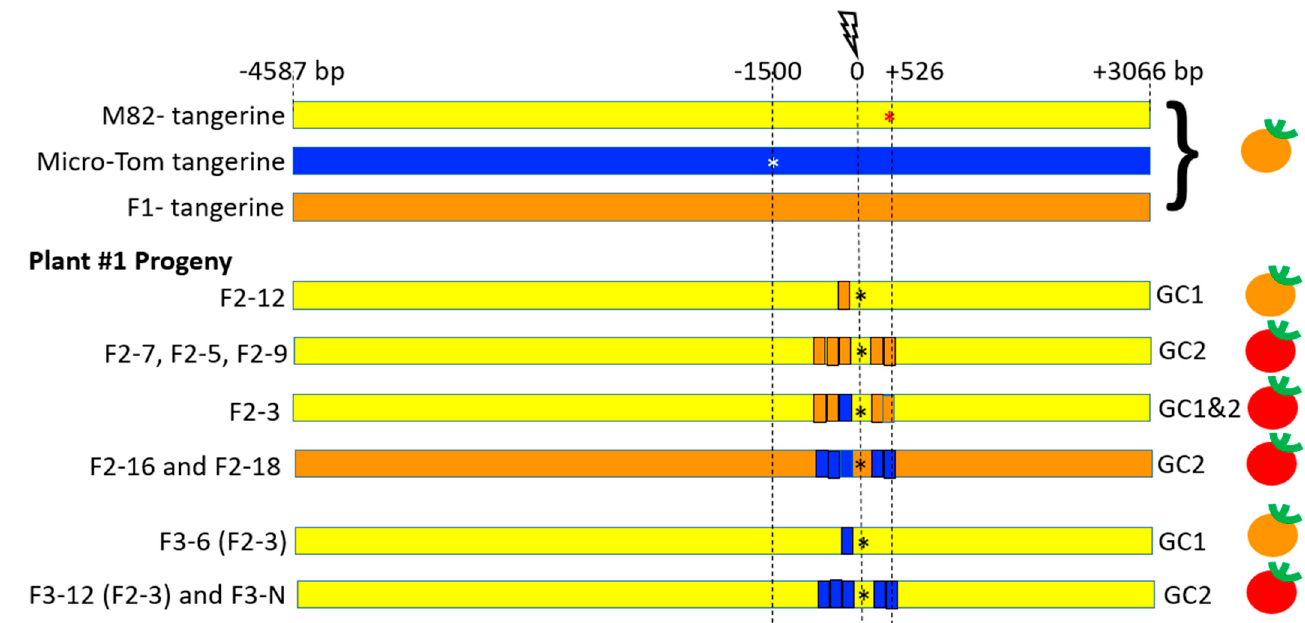
Figure 5. Schematic representation of IHSR events in the CRTISO 8–9 region around the targeted DSB in plant #1. The lightning bolt represents the CRISPR/Cas9 DSB site in the intron between exons 8 and 9 of the CRTISO locus. The DSB was induced between the two mutations in the tangerine alleles in the backgrounds of M82 (red star, 1500 bp upstream from the DSB) and Micro-Tom (white star, 526 bp downstream of the break). The F 1 has also a tangerine phenotype, unless an IHSR event occurs. In progeny of plant #1 where a red fruit sector was observed, two types of gene conversion events were observed. GC1 ′ s conversion tract did not span any of the two mutations and had a tangerine phenotype. For GC2, the conversion tract enabled to correct the close-by M82 mutation in a M82 chromosome background, giving rise to a dominant red fruit phenotype. SNPs that enabled the monitoring of the origin of the parental genotype are shown in yellow for M82 homozygotes, blue for Micro-Tom homozygotes, and orange for the heterozygote. Self-pollinated F 3 plants were grown to obtain a homozygous conversion tract and to confirm the sequence of these tracts and the plant phenotype. F 3 -N refers to several F 3 progeny that had the same genotype. The black star represents NHEJ DSB repair footprints that occurred in the intron, probably following recombination. The fruit color phenotype is indicated on the right side. A full detail of the various alleles’ sequences in all progeny is shown in Supplementary Figure S2.